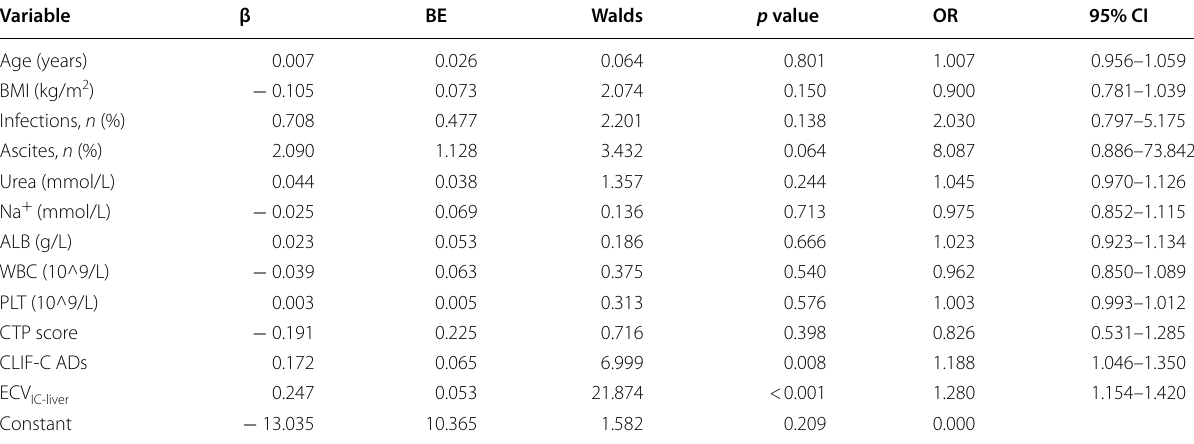
Table 3 Multivariate logistic regression analysis of risk factors associated with the occurrence of ACLF within 90 days based on the training group